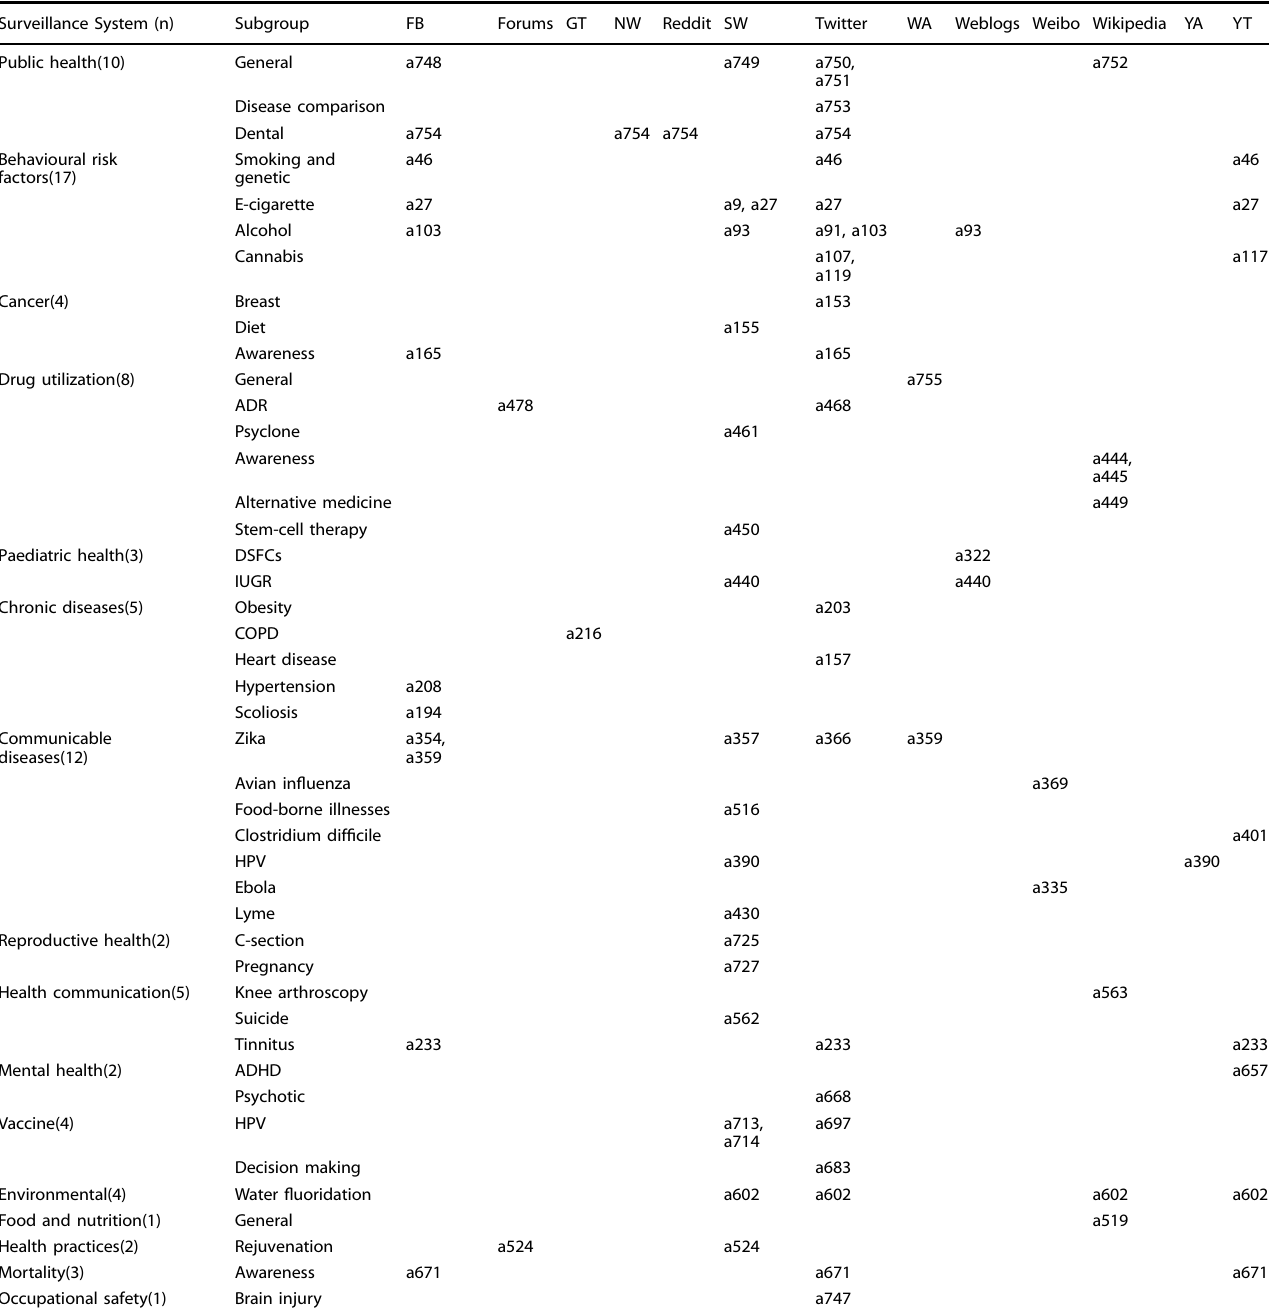
Table 2. Studies that detected inaccurate or incomplete information in the context of DPHS, mapped to various PHS themes/categories and digital media platforms. [FB]: Facebook, [NW]: News Websites, [SW]: Speci fi c Websites, [YA]: Yahoo Answers, [WA]: WhatsApp, and [YT]: YouTube. Surveillance System